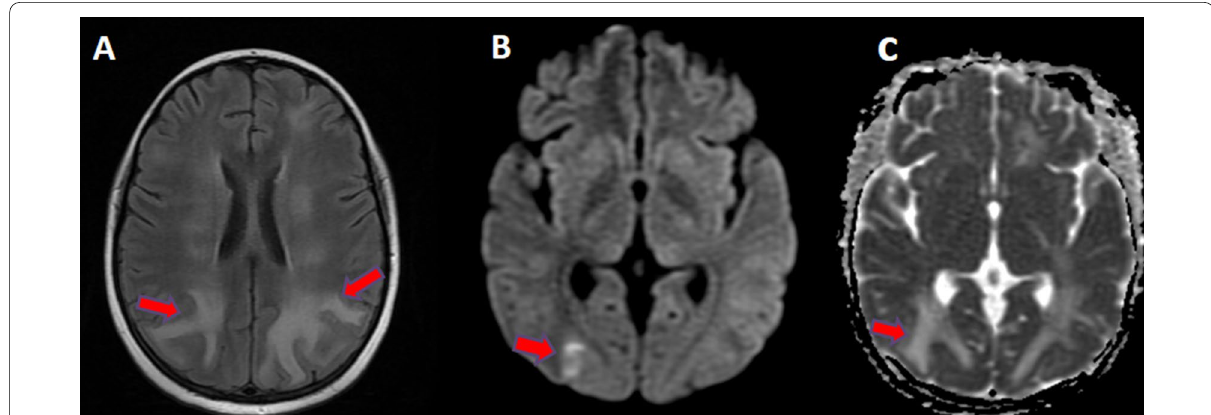
Fig. 5 A Axial FLAIR MRI image of brain demonstrates symmetrical hyperintense signal in white matter of bilateral parieto-occipital region with some cortical involvement (Red arrows). B , C Axial DWI and ADC image of brain demonstrates hyperintense signal in right occipito-temporal region (red arrows) with no corresponding decrease in ADC signal